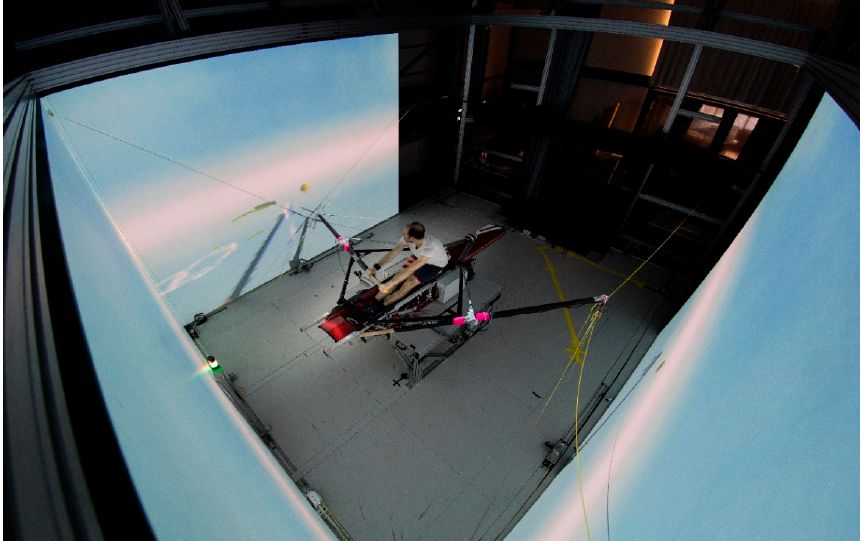
Figure 1. Rowing simulator setup with a shortened single scull boat and three screens surrounding the boat. The person rowing in the boat is the first author of the